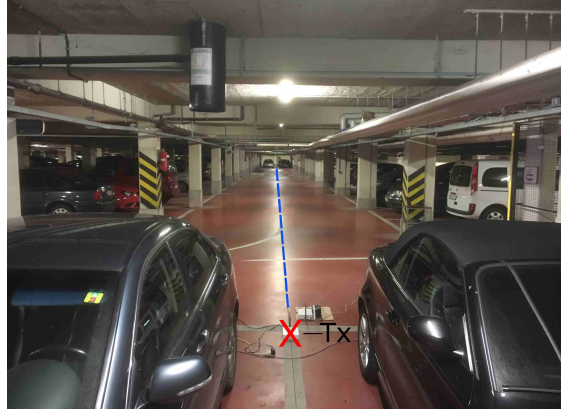
Figure 2. Scenario FW: the Tx location (red X) and the measurement path (dashed blue line ). In this picture, the parking garage is nearly full. Note the different features (such as pillars, water pipes, and ceiling relief) influencing propagation.